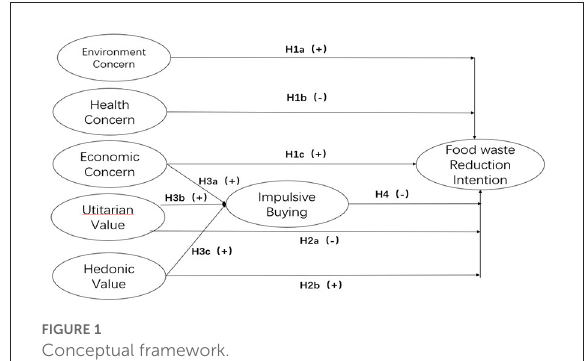
FIGURE1 Conceptual